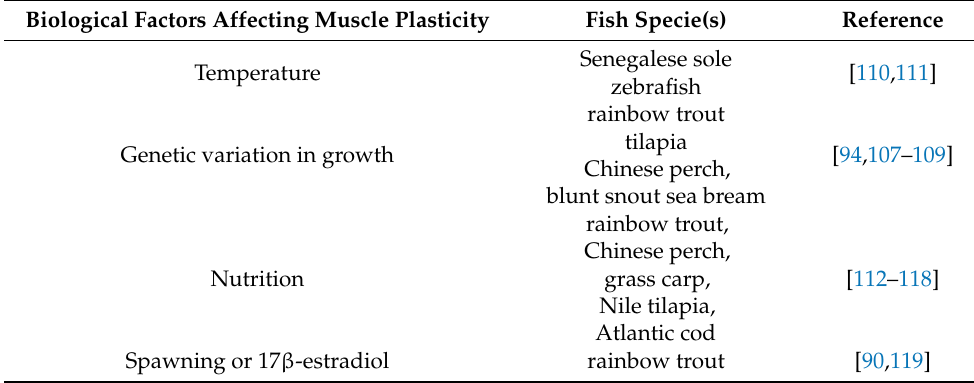
Table 3. Research in fish supporting miRNA-mediated regulation of muscle